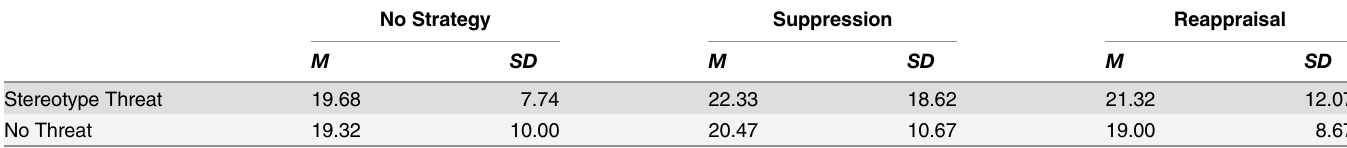
Table 2. Group Means and Standard Deviations of Number of Correct Answers in the Concentration Achievement Test (N =